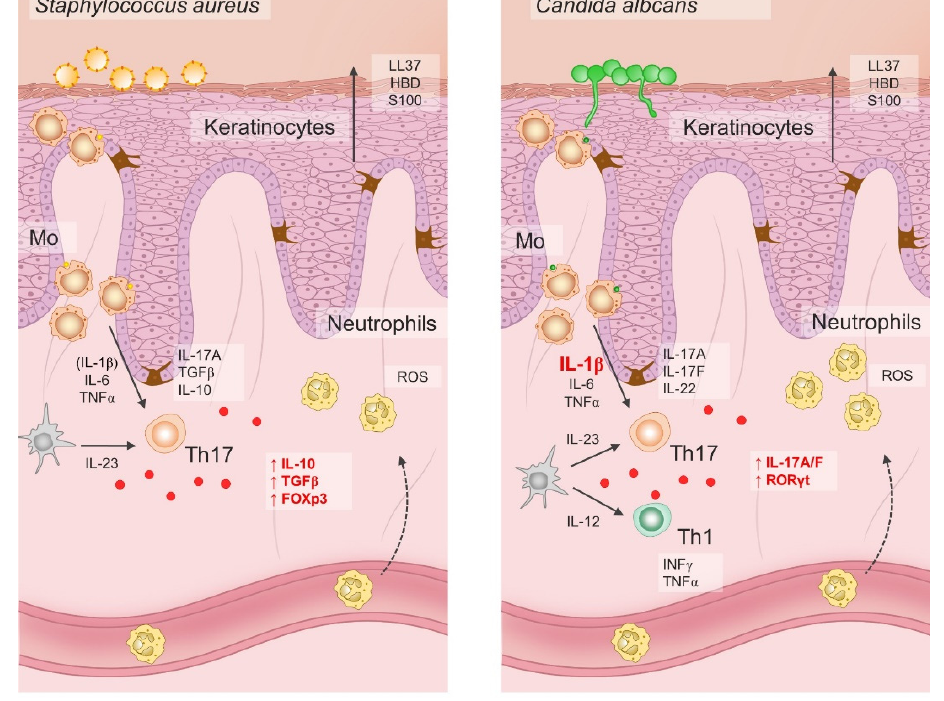
Figure 3. Dichotomous pathogen-specific Th17 responses under hypersaline tissue microenviron- ment depend on differential priming requirements for IL-1 β . depend on differential priming requirements for IL-1 β